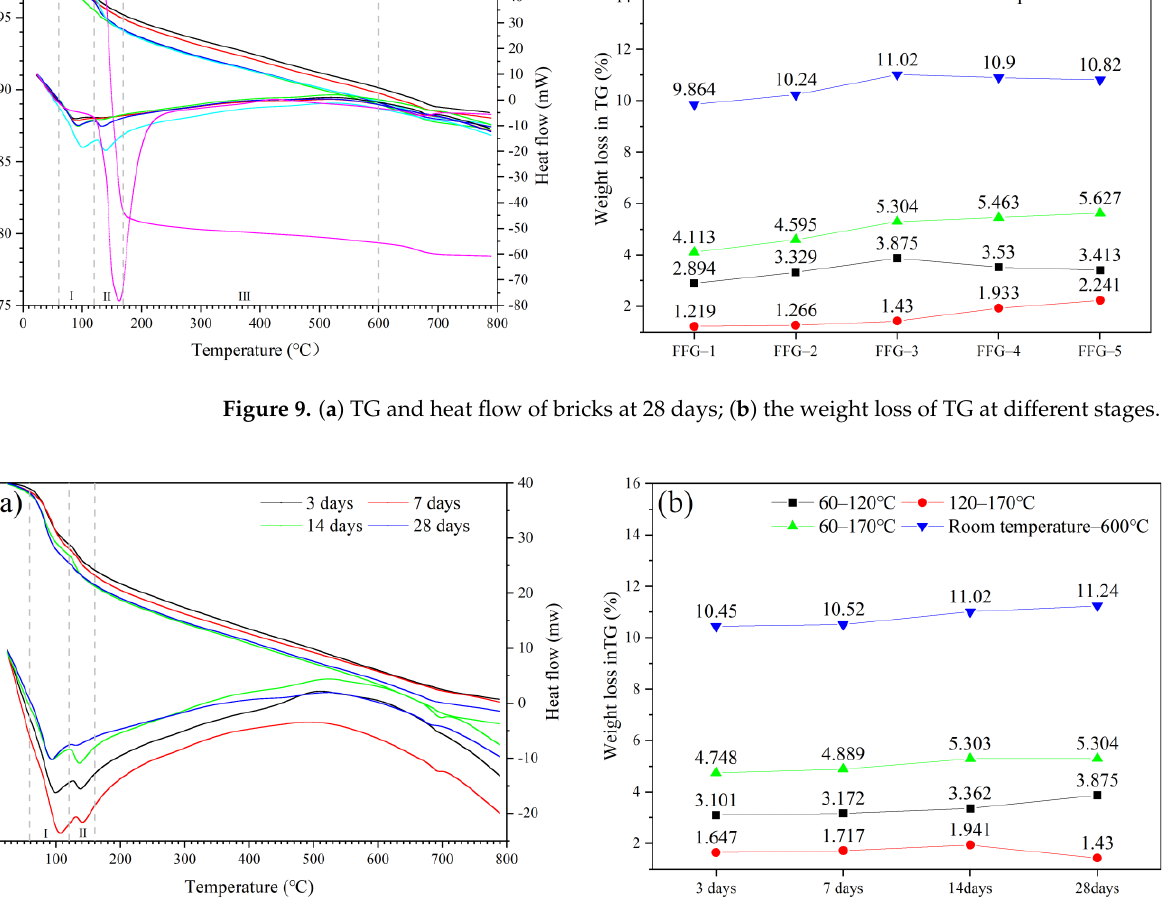
Figure 10. ( a ) TG and heat flow of FCG-3 at different ages; ( b ) the weight loss of TG at different stages.